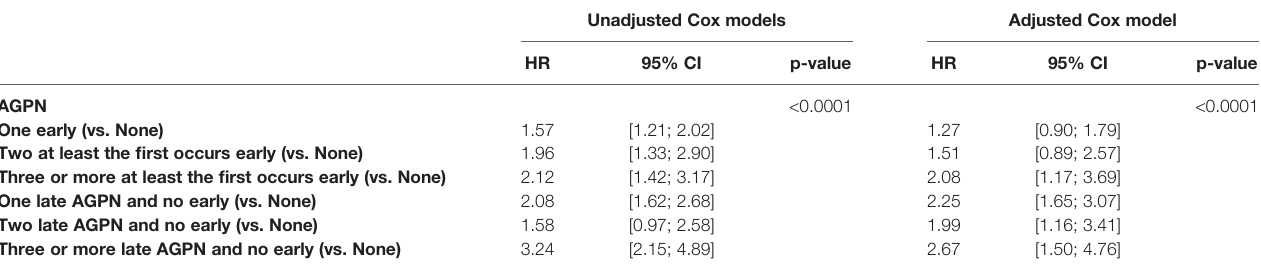
AGPN, acute graft pyelonephritis; CI, con fi dence interval; HR, hazard ratio.